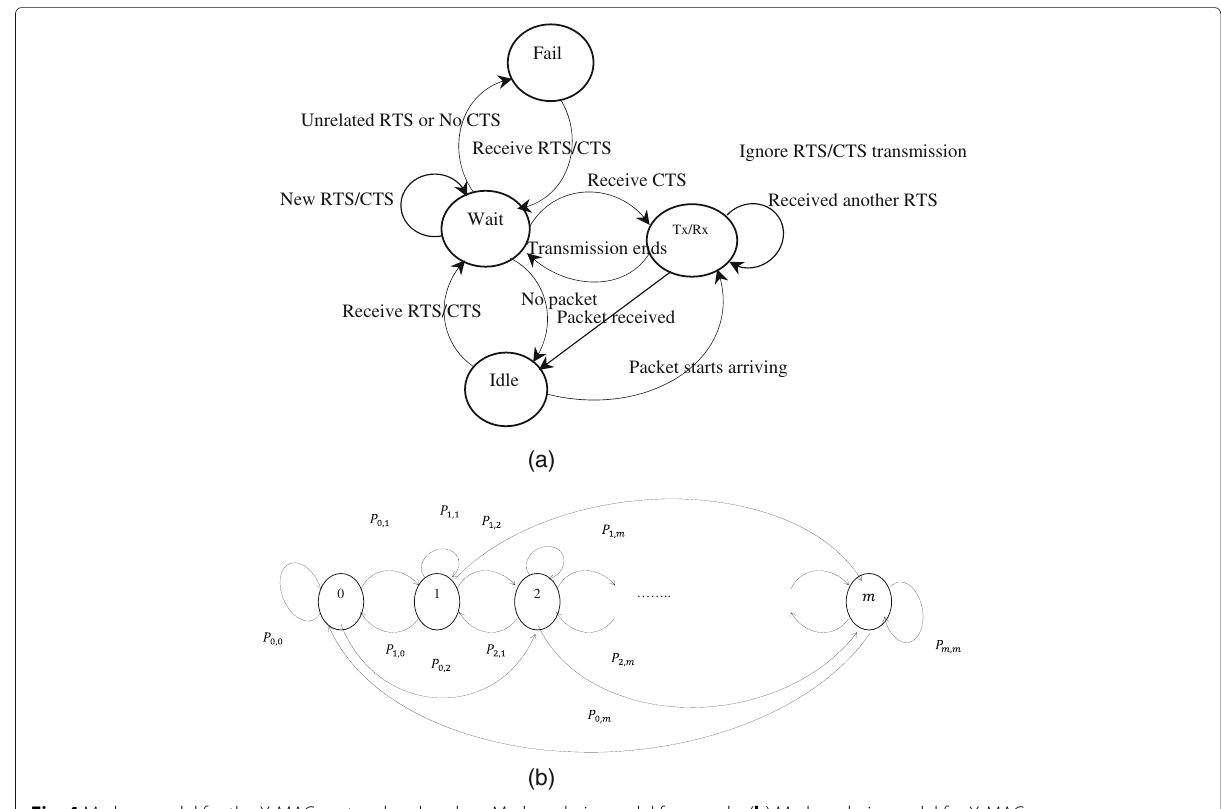
Fig. 4 Markov model for the X-MAC protocol and node. a Markov chain model for a node, ( b ) Markov chain model for X-MAC